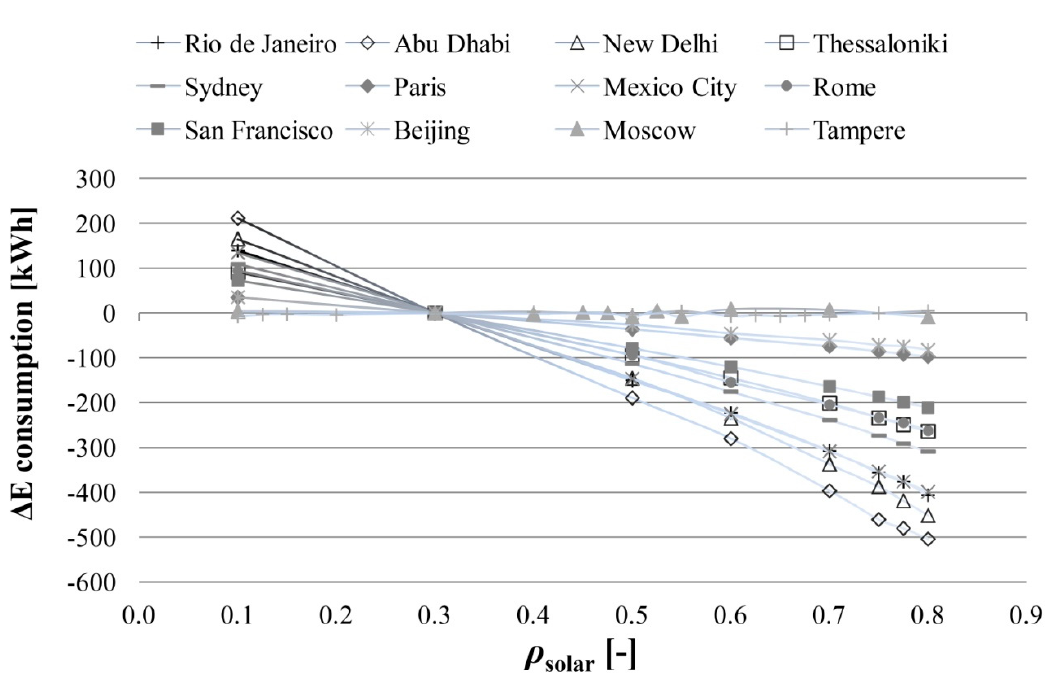
Figure 4. Variation of the annual building HVAC energy consumption di ff erence compared to the standard scenario varying only roof solar reflectance in each climate zone.